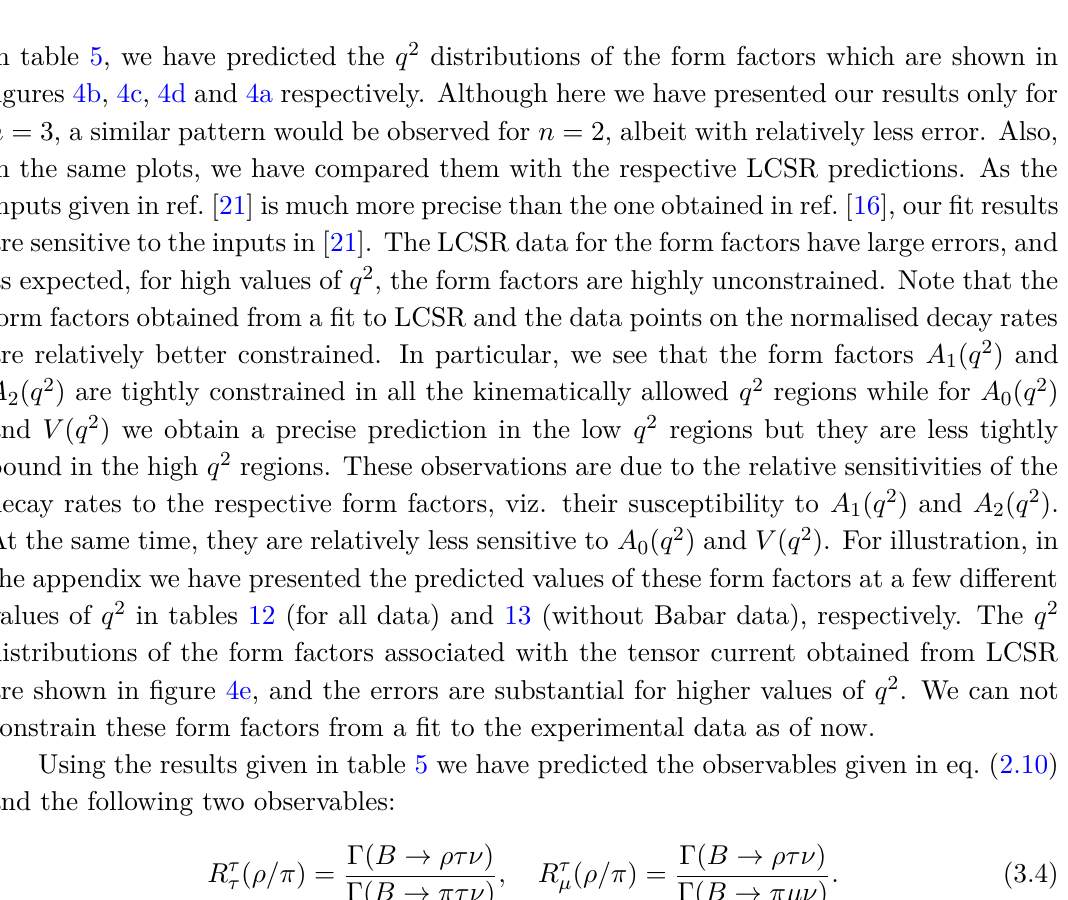
Figure 4. The comparison of the q 2 distributions of the form factors in B → ρ‘ν decays obtained from the fit results in table 5 for n = 3 and the one obtained only from the LCSR inputs. The tensor form factors can not be fitted from the experimental inputs that we have used in this